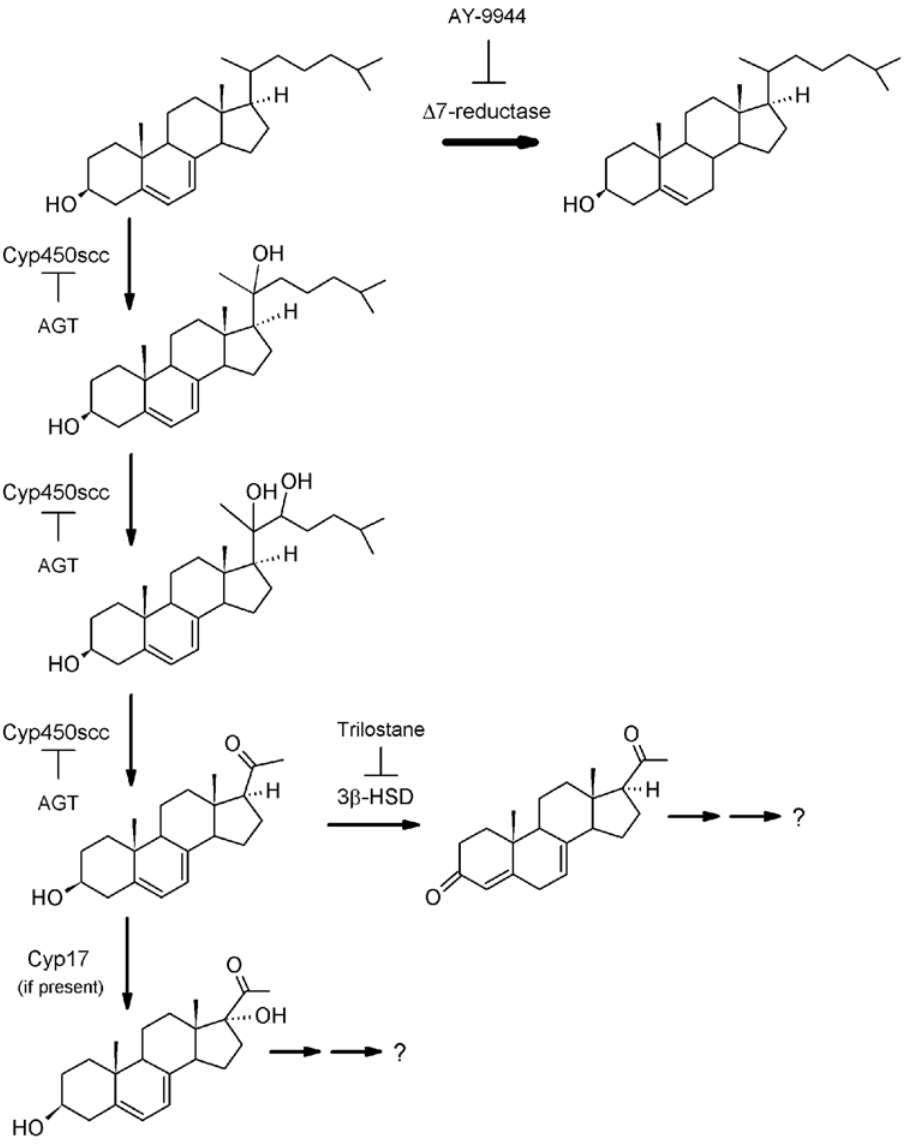
Figure 9. Proposed pathways for the invivo metabolism of 7DHC in the mammalian adrenal gland.